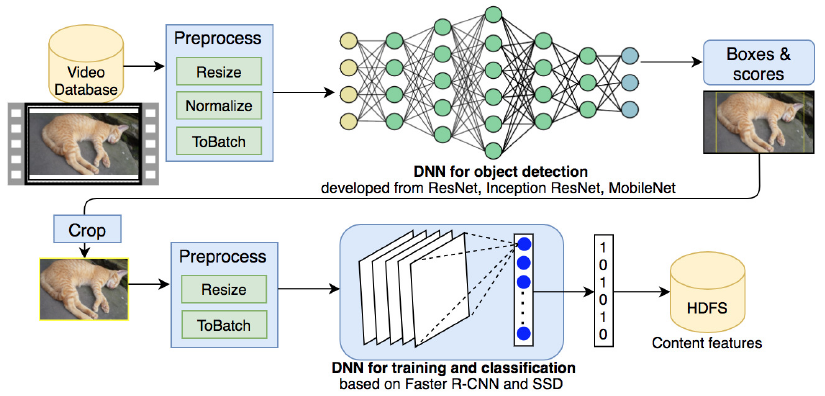
Figure 9. General model for object feature extraction from images in